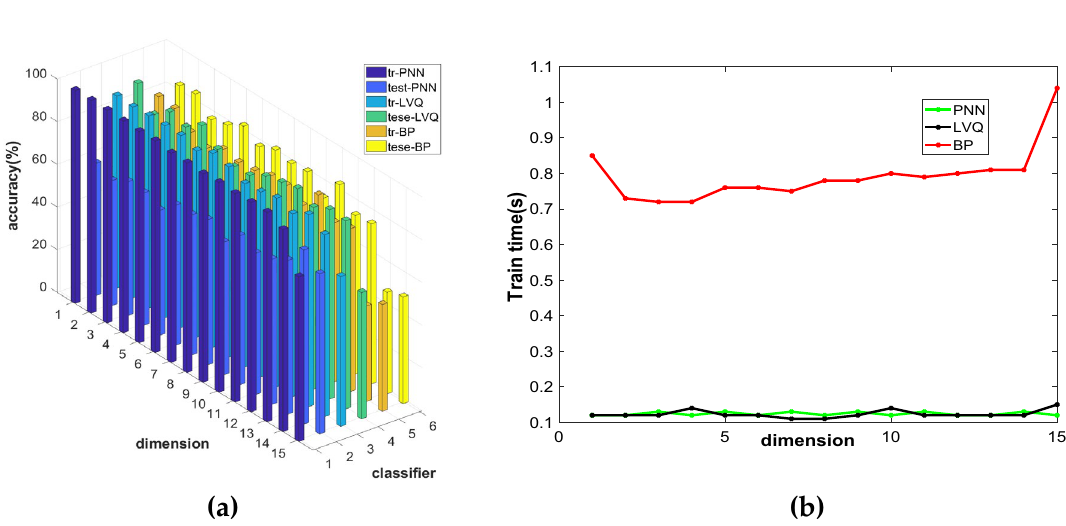
Figure 5. Comparison diagram of SNE-PNN, SNE-LVQ and SNE-BP models: ( a ) Accuracy comparison chart; ( b ) Comparison diagram of test